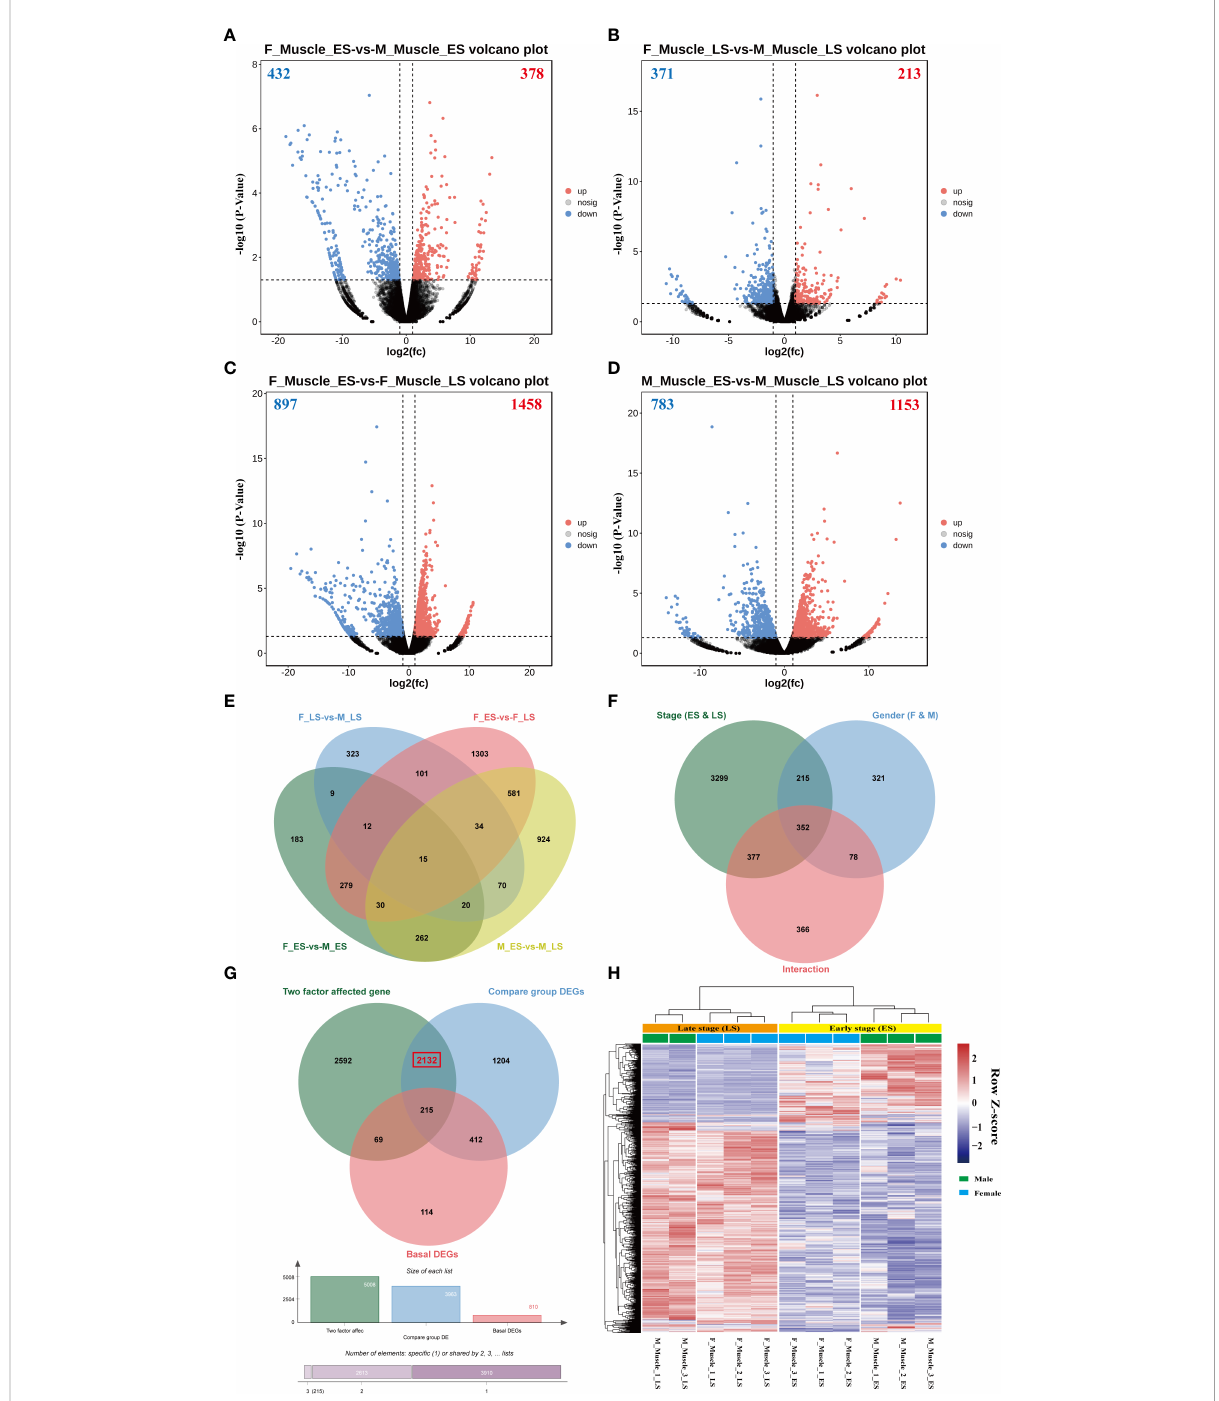
FIGURE 5 The DEGs between the different compared groups. (A, B) Volcano graphs based on the analysis of differential gene expression in the muscle of different sexes in the same period. (C, D) Volcano graphs based on the analysis of differential gene expression in the muscle of the same sex in different periods. (E) The Venn diagram of DEGs in different comparison groups. (F) The Venn diagram of the faltered DEGs in the muscle of the stage (ES and LS), sex (female and male), and interaction (main treatment and main period). (G) The Venn diagrams of the data, illustrating the overlap of three parts (two-factor affected unigenes, DEGs, and basal DEGs) in the muscle in the comparison of different libraries. The red box indicates DEGs that were signi fi cantly affected by the two factors (stage and sex). (H) The analysis performed based on the FPKM values of 2132 DEGs in the muscle that were signi fi cantly affected by the two factors; the legend shows the row